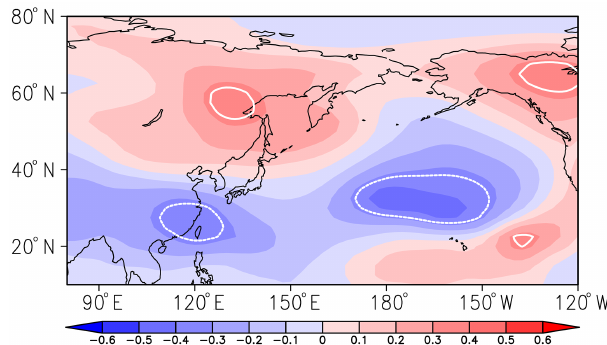
Figure 7. The CC between predictor x 3 ( ×− 1) and Z500 DY (shade)/850hPa wind DY (arrows) in winter from 1980 to 2013. The dots indicate that the CC with meridional wind exceeded the 95% confidence level. A and C represent anticyclone and cyclone, respectively.